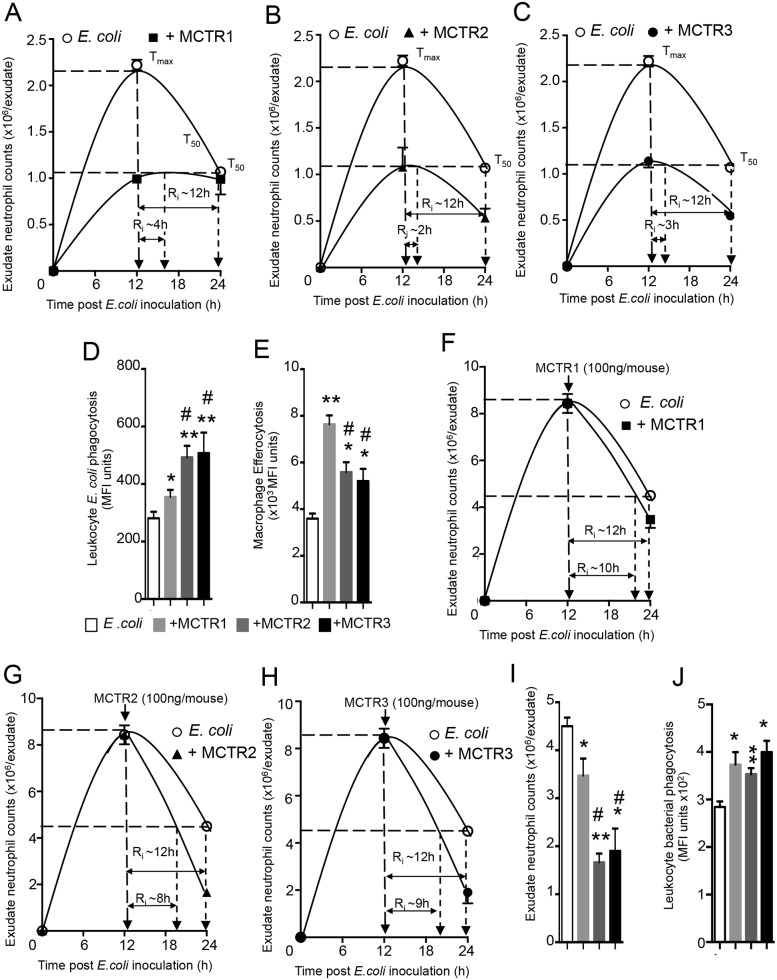
MCTRs accelerate resolution of E. coli infections.(A-E) Mice were administered (A) MCTR1, (B) MCTR2, (C) MCTR3 (50ng) or vehicle (saline containing 0.1% EtOH) via i.p injection; after 5 min they were inoculated with E. coli (105 CFU/mouse) and exudates collected at the indicated time intervals; peritoneal leukocyte counts and resolution indices were determined (See Materials and Methods). (D) E. coli phagocytosis by exudate leukocytes was determined as median fluorescence units (MFI) in the CD11b+E. coli+ population at 12h (E) Exudate macrophage efferocytosis was determined as MFI in the F4/80+Ly6G+ population. (F-J) Mice were inoculated with E. coli (105 CFU/mouse). After 12h, exudates were collected or (F) MCTR1, (G) MCTR2, (H) MCTR3 (100ng) or vehicle was administered via i.p. injection and peritoneal exudates collected 24h after E. coli inoculation; leukocyte counts were assessed and resolution indices determined. (I) 24h exudate leukocyte counts (see Materials and Methods). (J) E. coli phagocytosis by exudate leukocytes was determined as MFI in the CD11b+E. coli+ population. Results are mean±sem. n = 3 or 4 mice per group. *p<0.05, **p<0.01 vs. E. coli mice. #p<0.05 vs. E. coli + MCTR1.